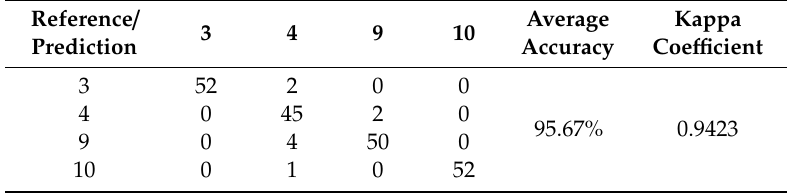
Table 11. Confusion Matrix using the SVM classifier in zones 3, 4, 9 and 10.